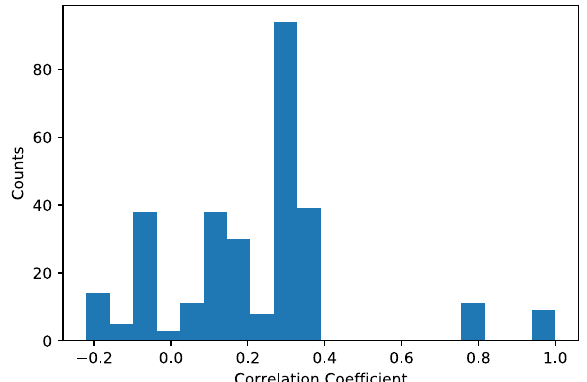
Figure 7. Community correlation between notes of different ancestry networks. Histogram of Pearson product- moment correlation coefficients for shared community members between the same trait in different ancestry networks. The count represents number of traits that have the given correlation